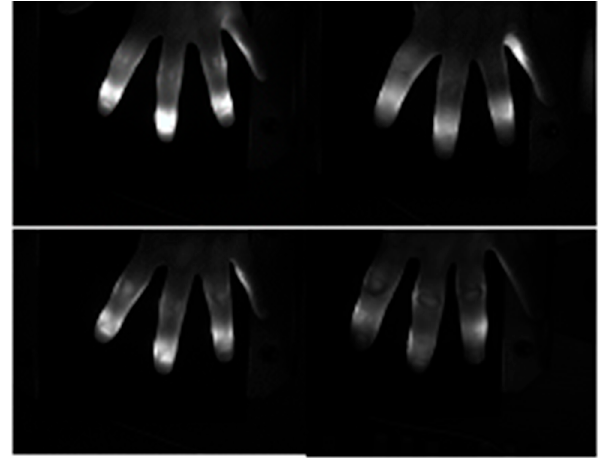
Figure 5. Four sample subjects from the near-infrared (NIR) dataset.